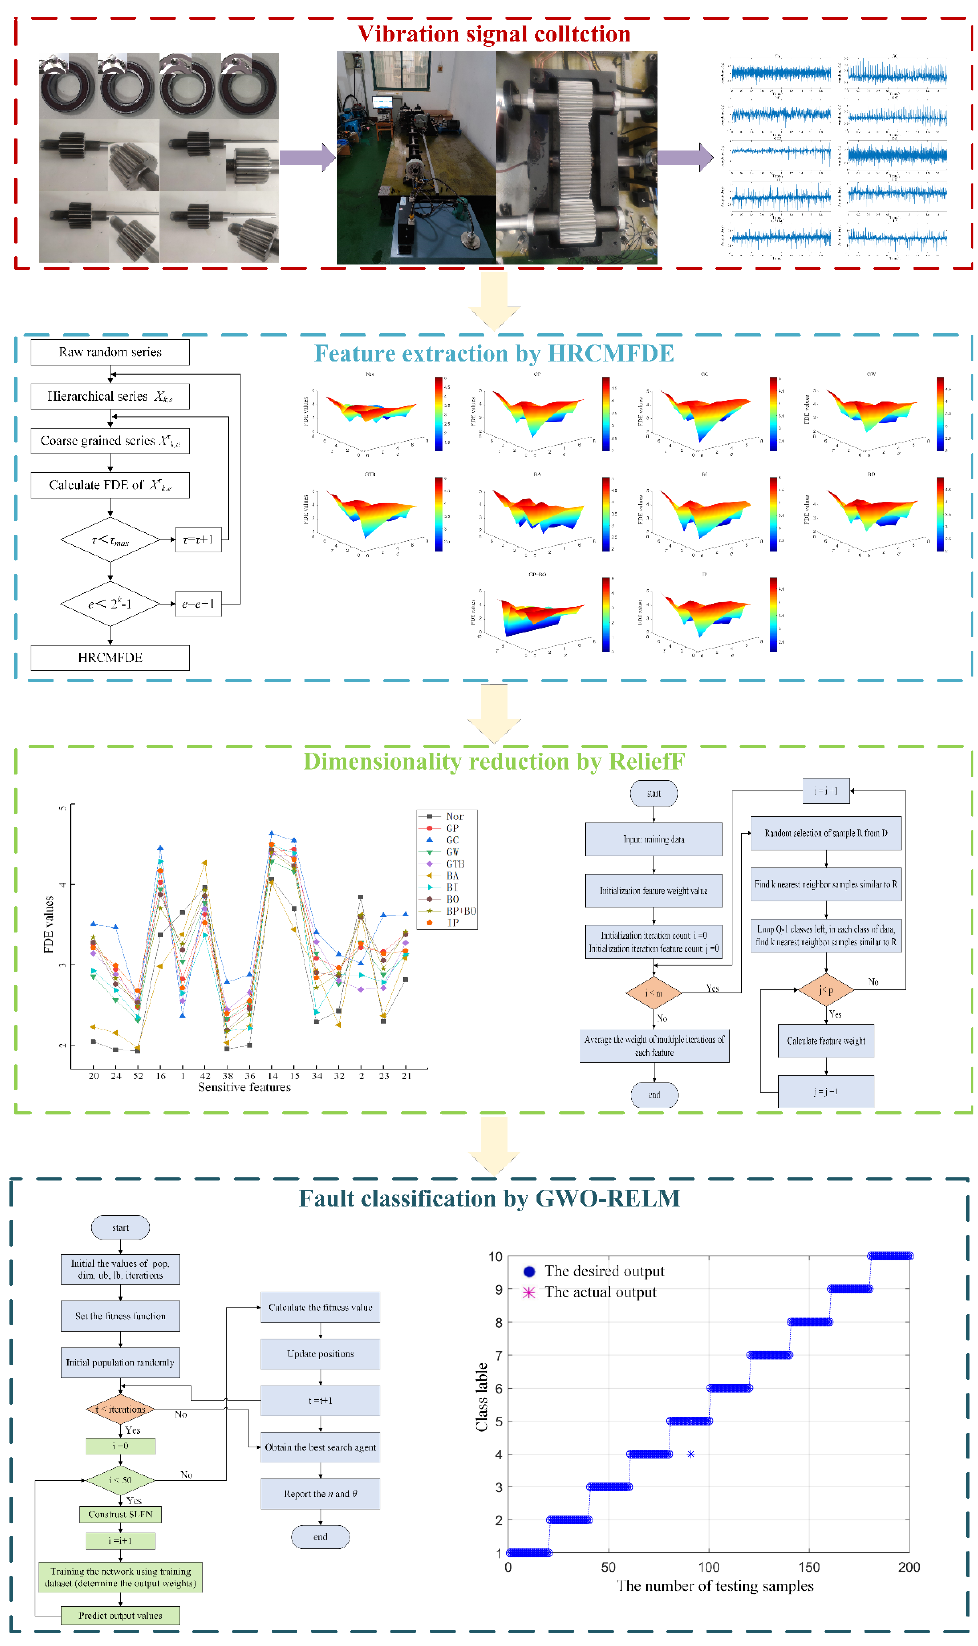
Figure 6. Flowchart of the proposed fault diagnosis method.